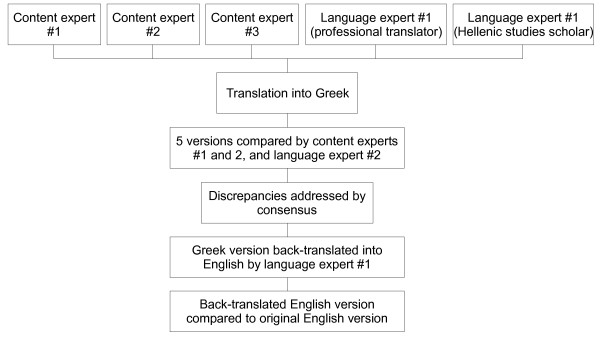
Translation process.